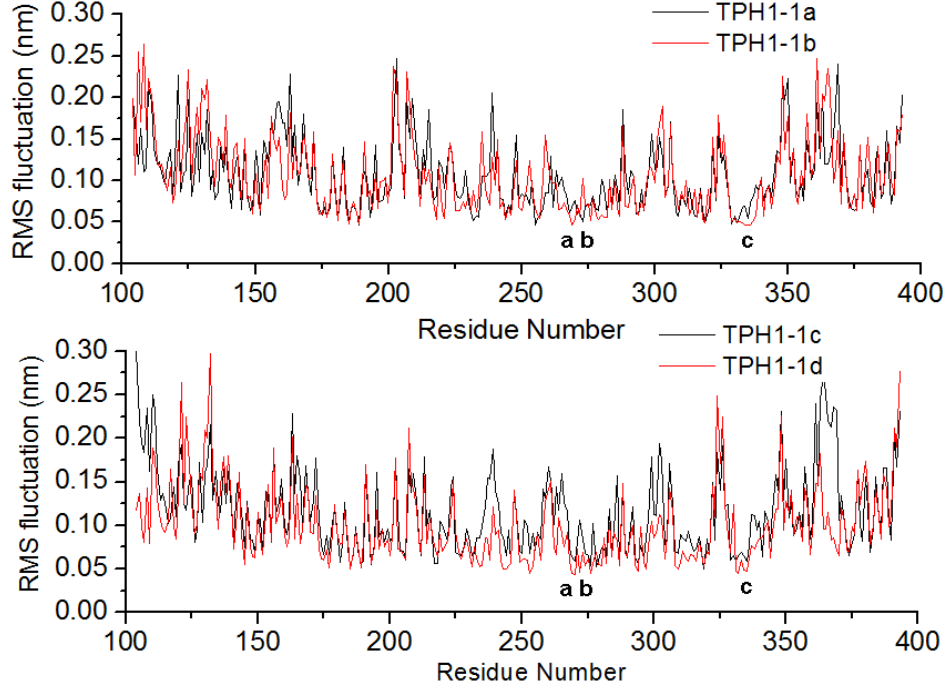
Figure 3. Root-mean-square fluctuation (RMSF) of the backbone atoms (CA, N, C) versus residue numbers for the TPH1–inhibitor complexes. The residues a, b and c were Asp269, His272 and Ser336,